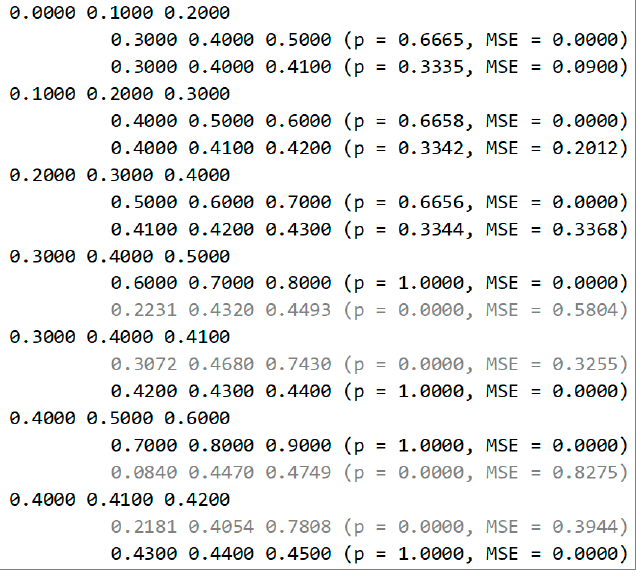
Figure 11. The prediction results for the asymmetric bimodal